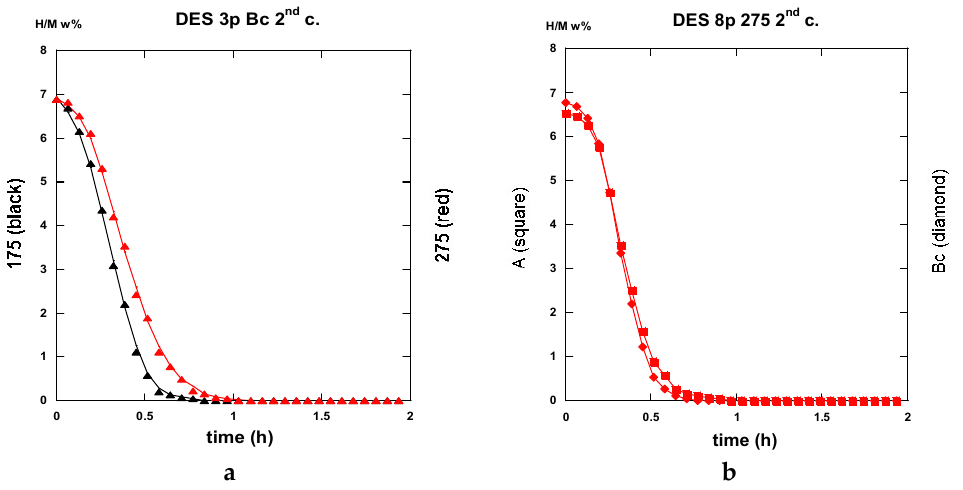
Figure 31. Comparison of the 2nd desorption rate traces (H/M w%) of: a—three passes B C route ECAP treated at 175 and 275 °C. b—Eight passes ECAP-treated at 275 °C for A and B C routes.